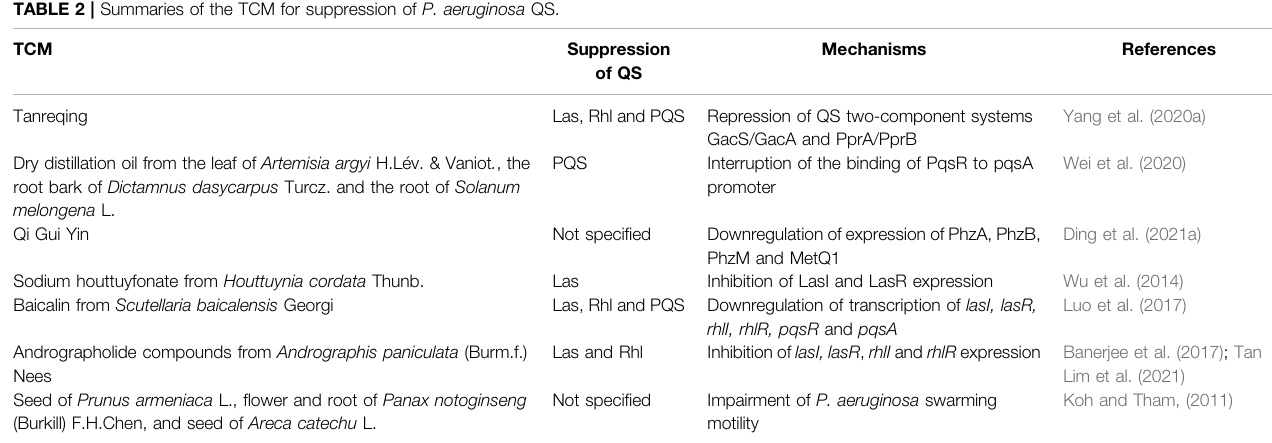
TABLE 2 | Summaries of the TCM for suppression of P. aeruginosa